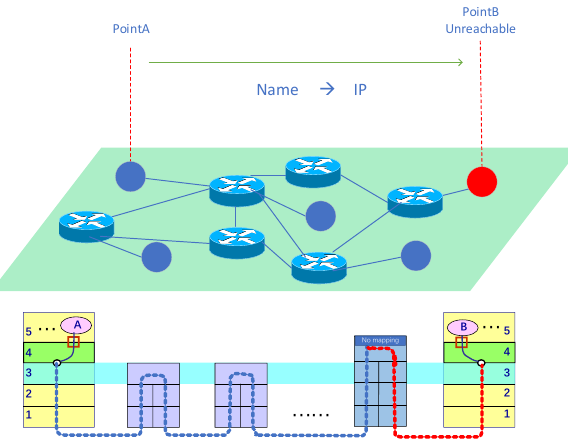
Figure 3. Unreachable nodes are discarded directly from the